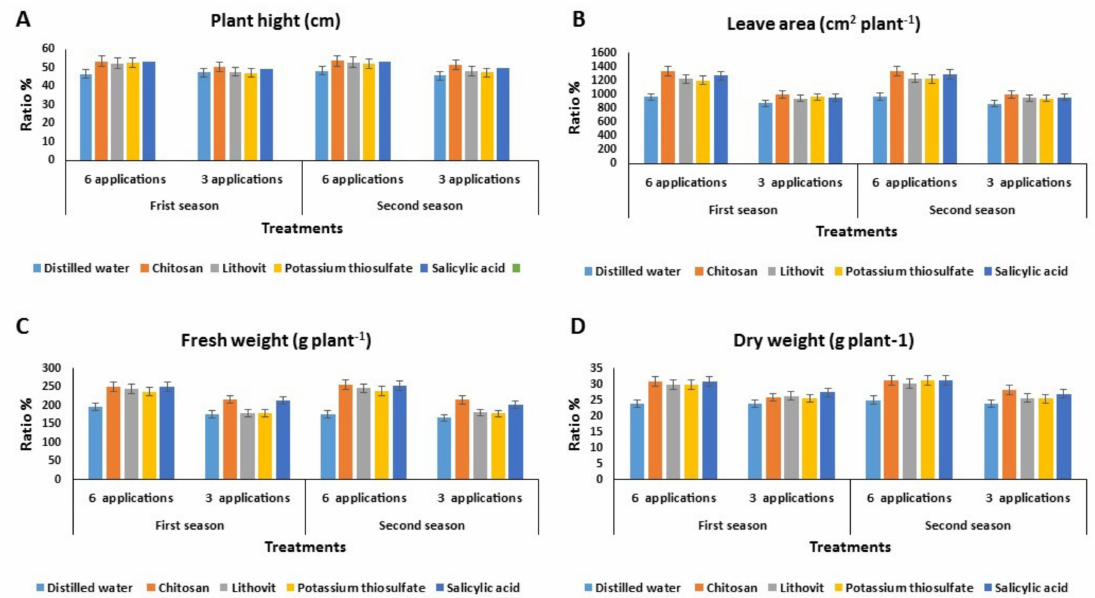
Figure 1. The e ff ect of the four tested chemicals as pre-harvest foliar application on vegetative growth characters of tomato plants during two growing seasons 2017 and 2018. ( A ) Plant height (cm), ( B ) leaf area (cm 2 plant − 1 ), ( C ) fresh weight (g plant − 1 ), and ( D ) dry weight (g plant − 1